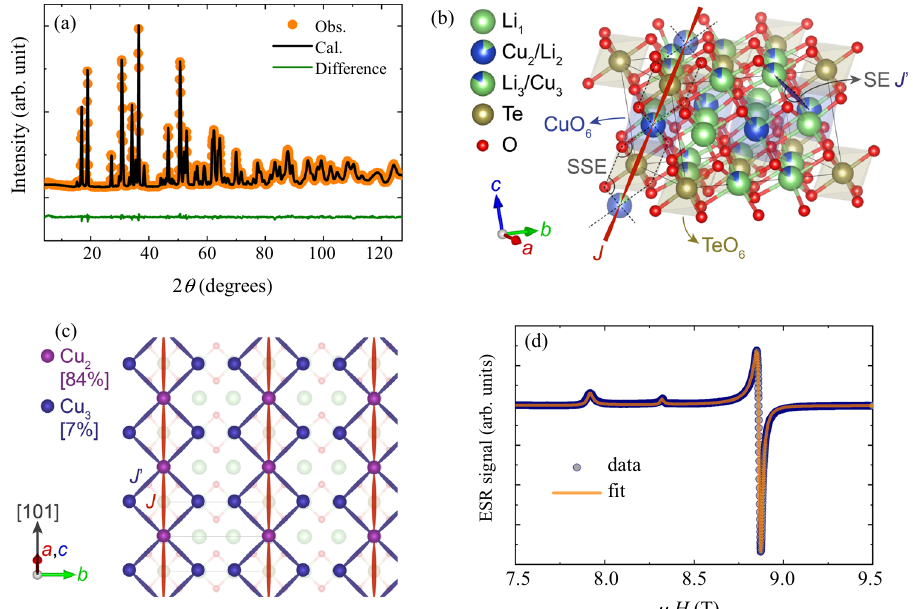
Fig. 1 Crystal structure and high-temperature spin model of Li 4 CuTeO 6 . a Rietveld re fi nement of neutron-diffraction data of LCTO at room temperature for the incident wavelength 1.28 Å . The solid circles represent the observed intensity (Obs.), whereas the black solid line is the calculated intensity (Cal.). The residual signal is denoted by a green solid line and is shifted vertically for clarity. b Visualization of one unit cell of LCTO where edge-sharing TeO 6 and CuO 6 octahedra connect Cu 2 + ions on 2 d (Cu 2 ) sites with an exchange J through a Cu – O ⋯ O – Cu super-superexchange (SSE) bridge around Te 6 + . Additionally, corner-sharing CuO 6 octahedra connect Cu 2 + ions on 2 d (Cu 2 ) and 4 g (Cu 3 ) sites with an exchange J 0 through a nearly-linear Cu – O – Cu superexchange (SE) bridge. c Resulting spin model of randomly depleted 1D spin chains of Cu 2 sites with antiferromagnetic exchange J running along the [101] direction, to which randomly occupied Cu 3 sites couple via an antiferromagnetic exchange J 0 and introduce strong frustration. d The electron spin resonance (ESR) spectrum of LCTO measured at 250 K and 256.3 GHz (points). The fi t (solid line) includes two components with uniaxial symmetry and a Lorentzian line